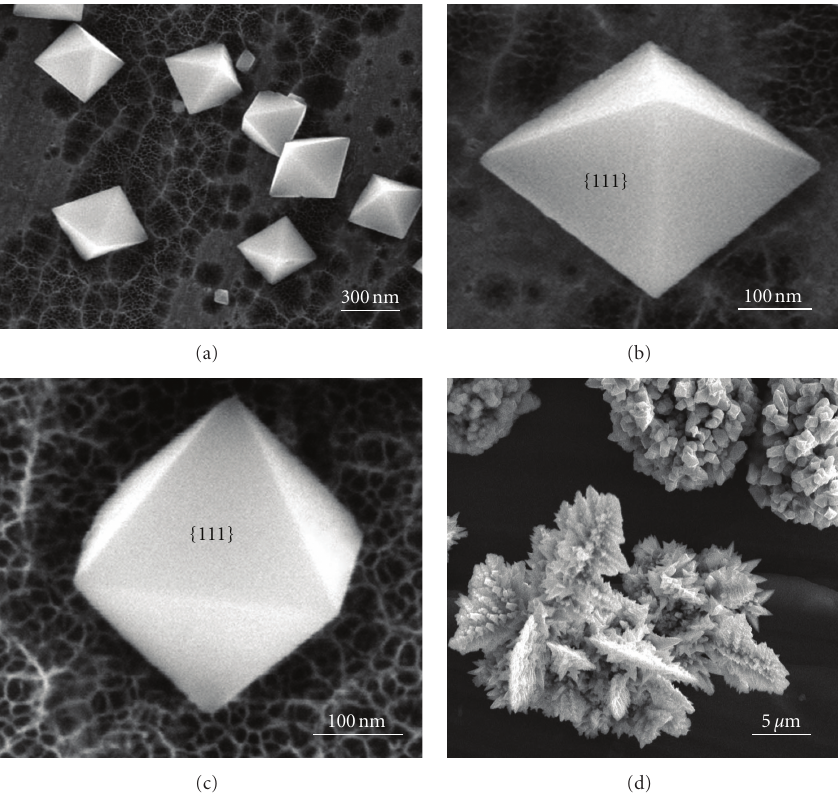
Figure 1: (a) Low-magnification SEM image of as-deposited specimen; (b) and (c) enlarged SEM images of as-deposited specimen; (d) SEM image of as-deposited specimen without lactic acid in the